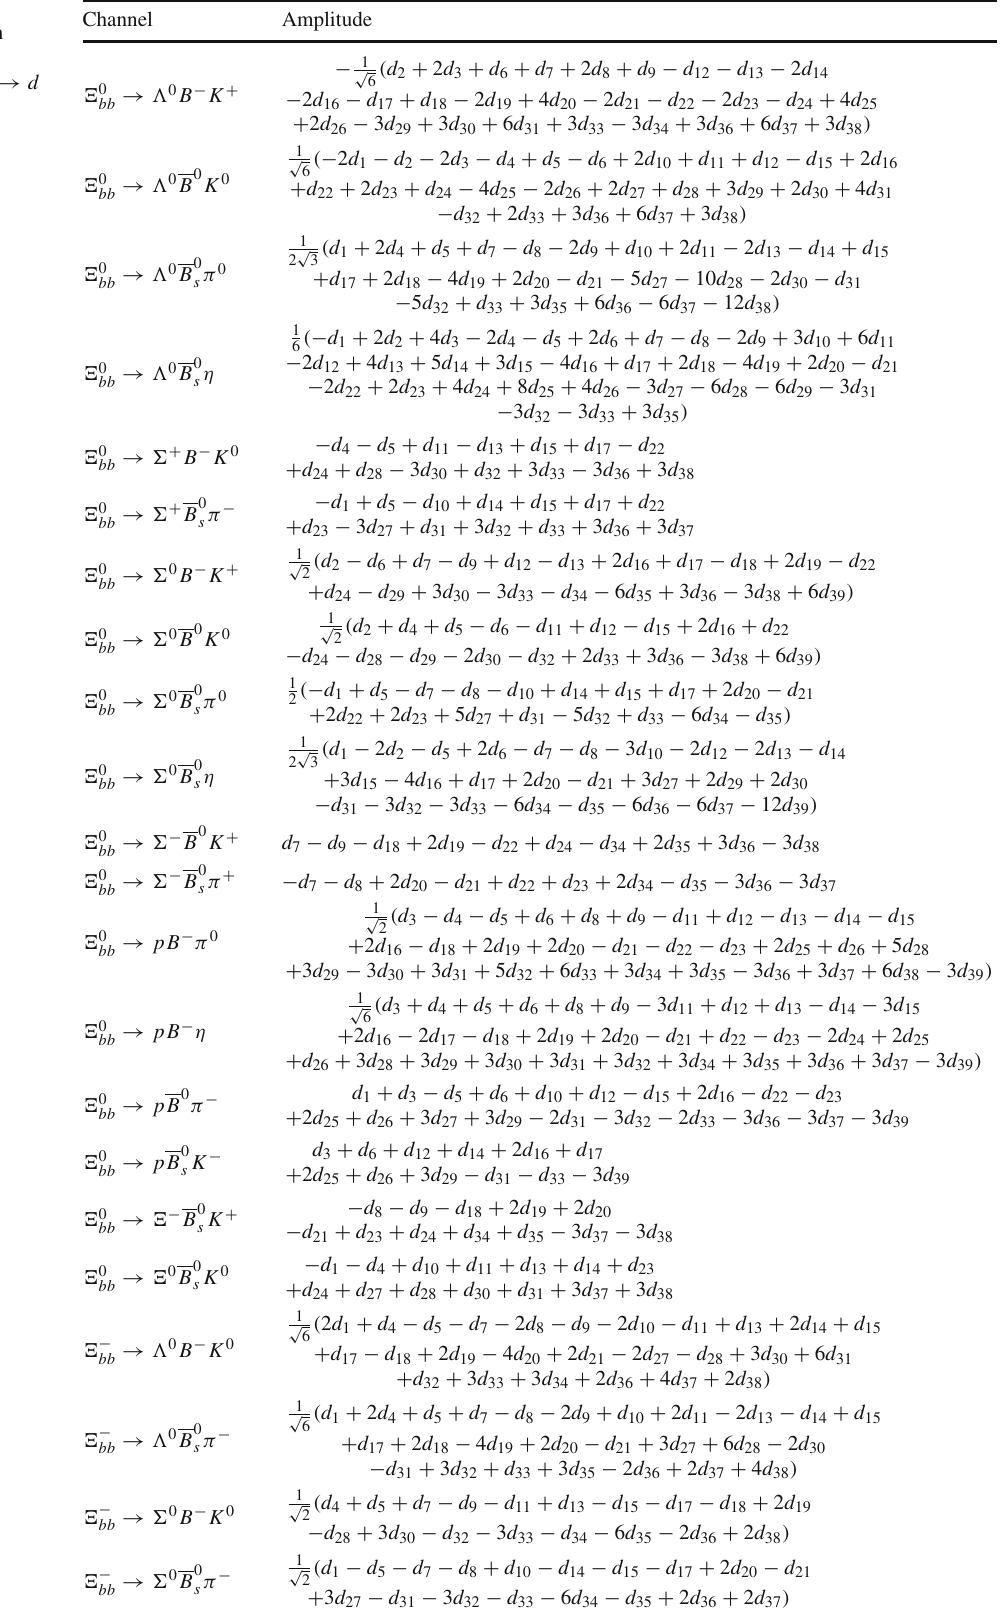
Table 28 Doubly bottom baryon decays into a bottom meson, a light baryon(8) induced by the charmless b → d transition and a light